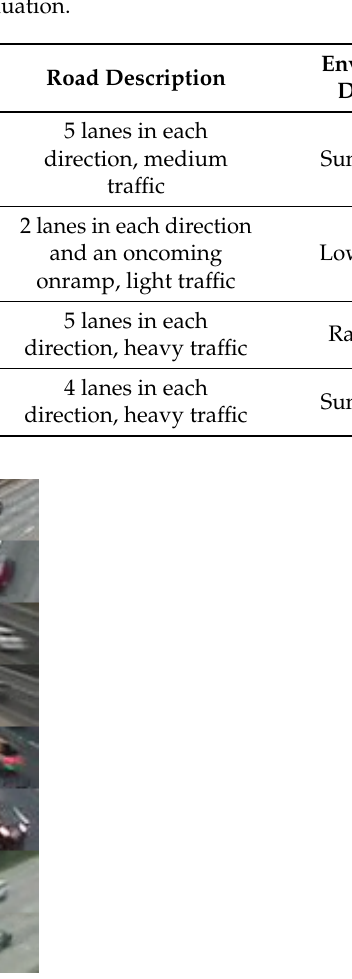
Table 1. Description of sample videos for evaluation.